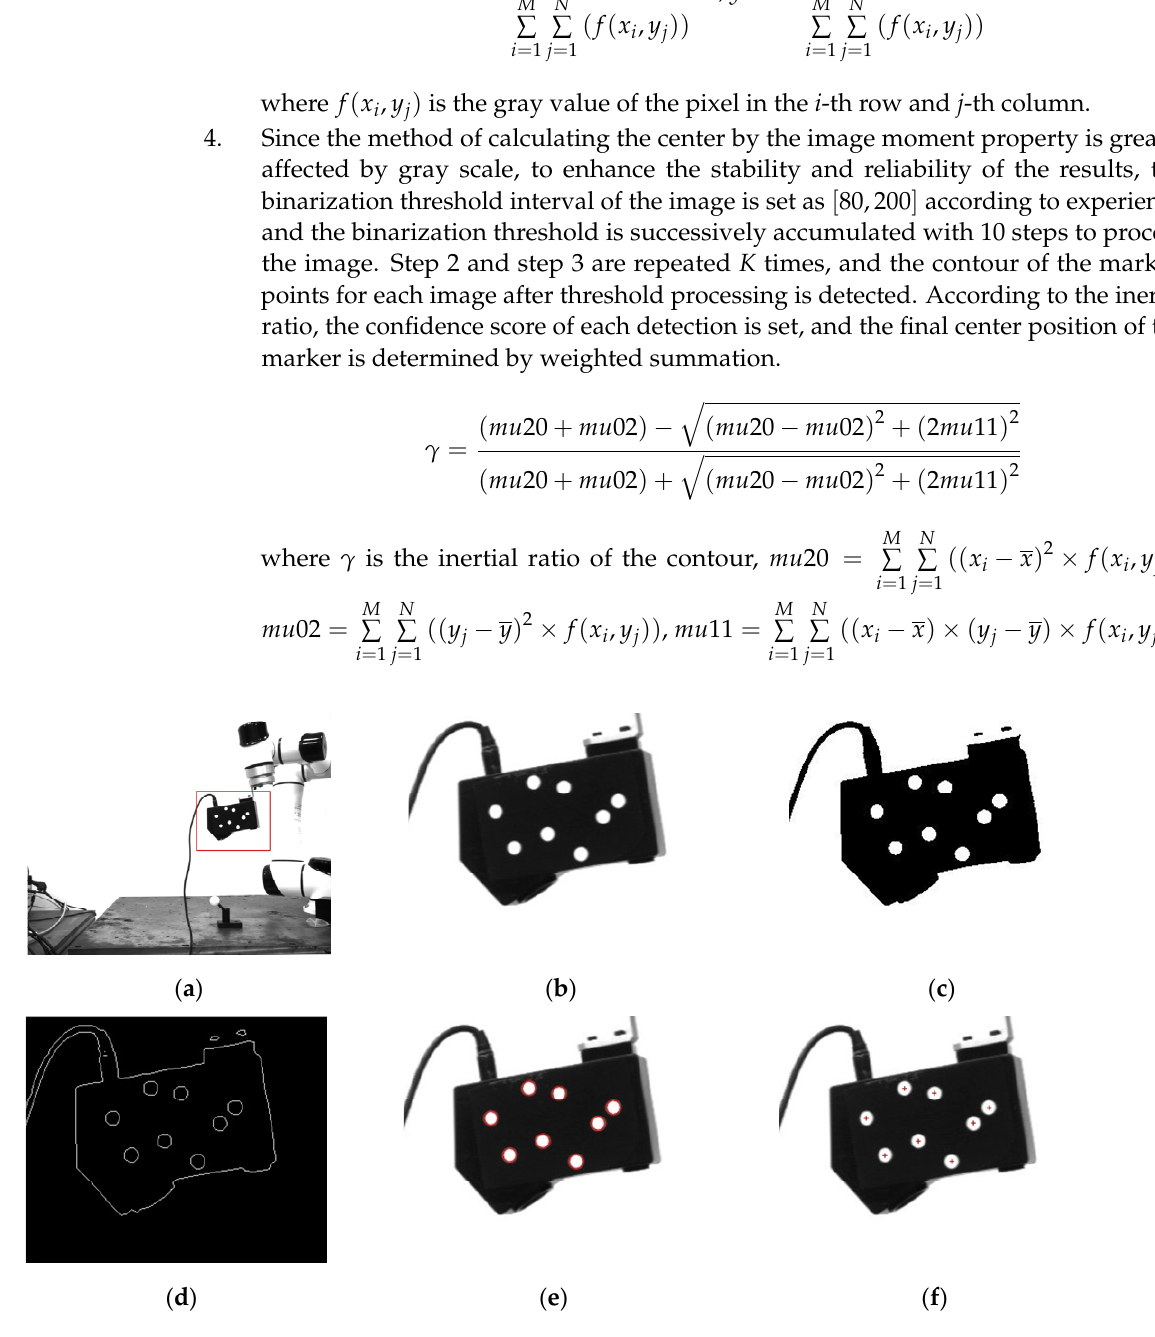
Figure 3. ( a ) Template matching image. ( b ) Region of interest image. ( c ) Binary image. ( d ) Edge detection image. ( e ) Contours image. ( f ) Center marked image.